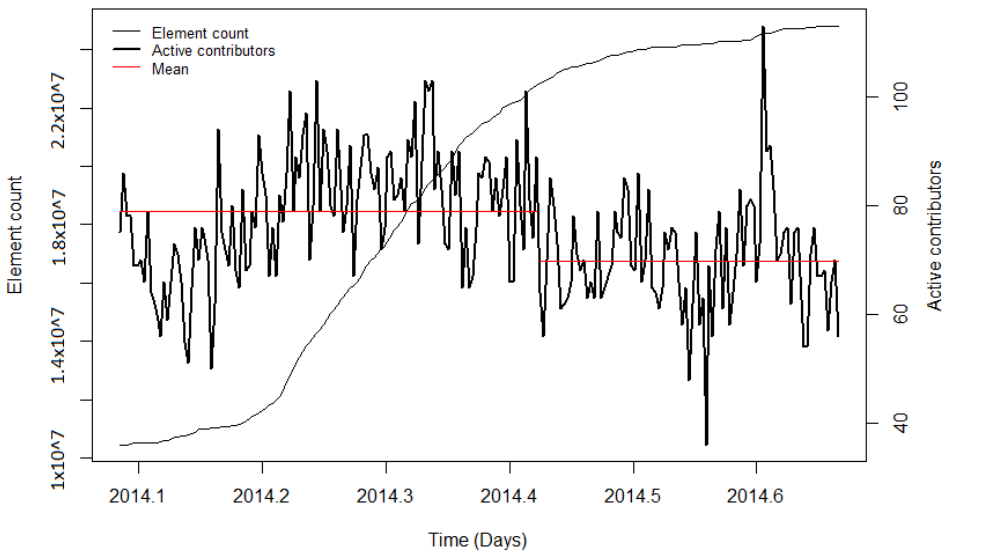
Figure A3. Contributor activity during the BAG